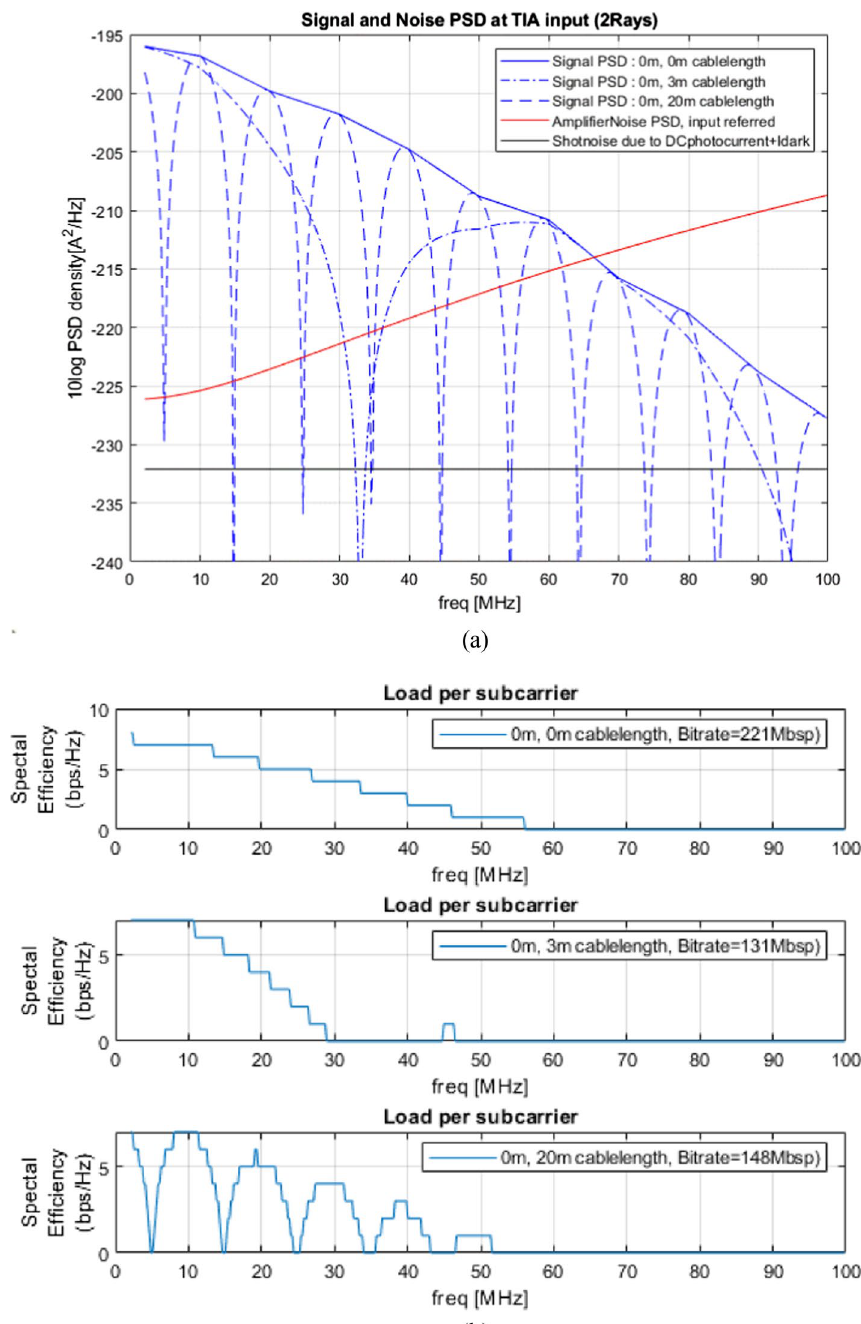
Fig. 21 a Received signal strength and noise floor for a two-ray SISO transmission in the middle of two emitters connected with a cable length difference of 0, 3 and 20 m. b Resulting estimated bit